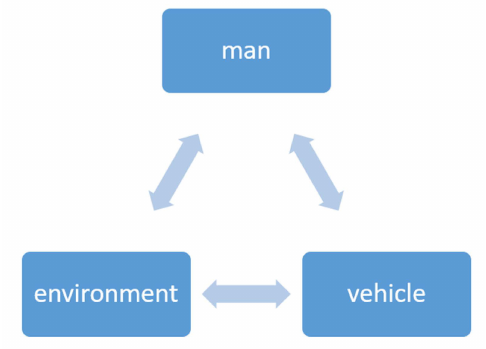
Figure 2. Safety